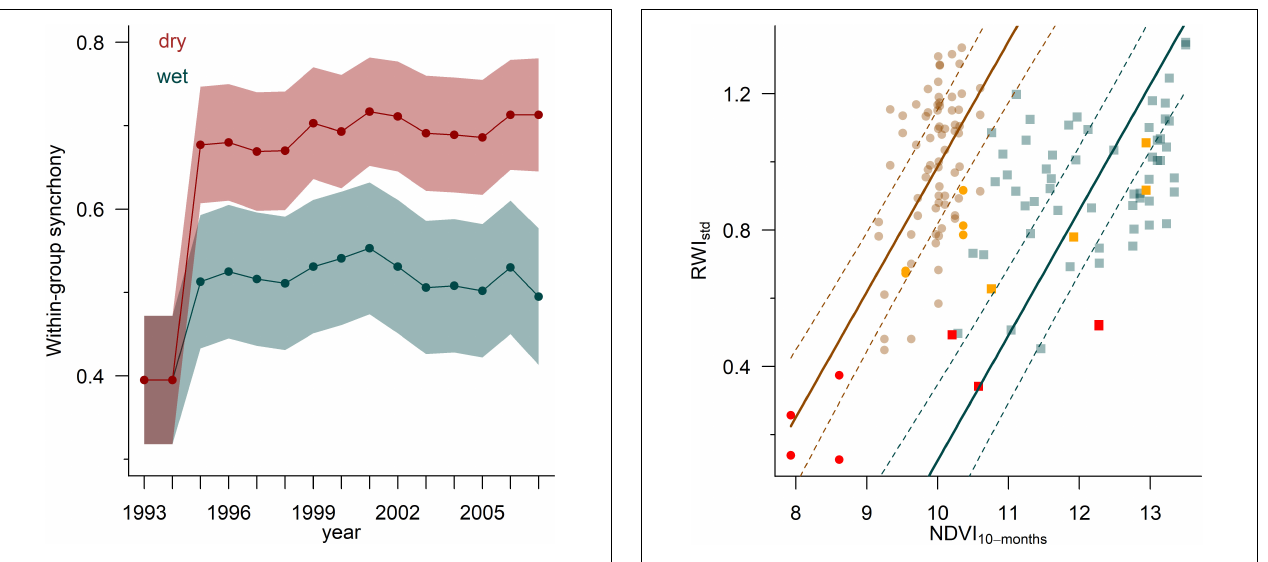
FIGURE 5 | Relationship between the standard tree-ring width chronologies (RWIstd) and the 10-month long cumulative NDVI for November in dry (brown circles) and wet (blue squares) sites. The lines show the effect of NDVI on RWIstd according to the linear-mixed effect models (see Supplementary Table S5 ) and the dashed lines show the 95% confidence intervals for the predictions. Red and orange symbols show the values observed in the 2005 and 2016 droughts,